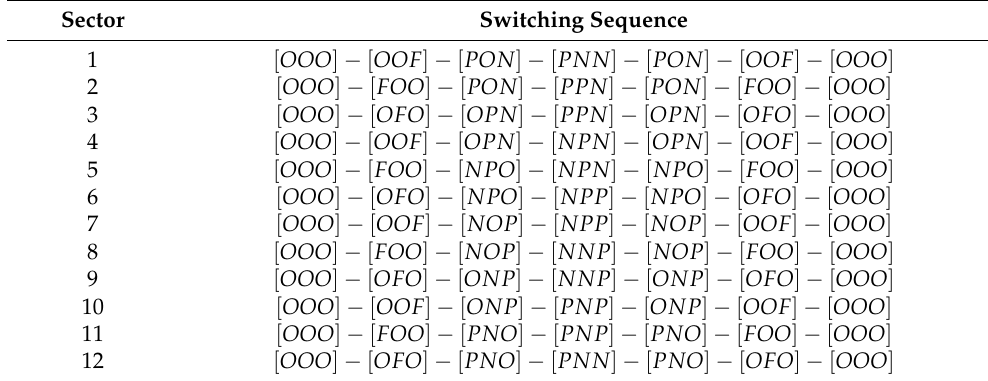
Figure 2. Space vector diagram of LMZVM. Table 3. The switching sequence of